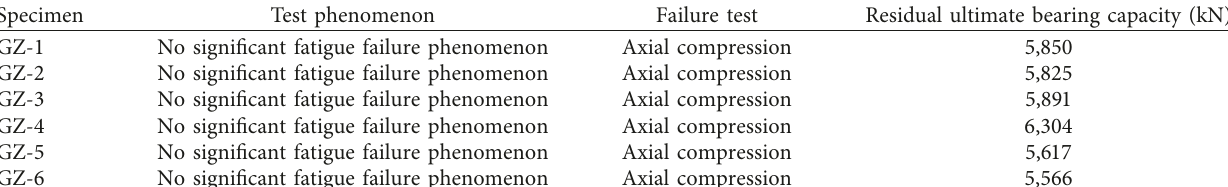
Table 2: Summary of test results.